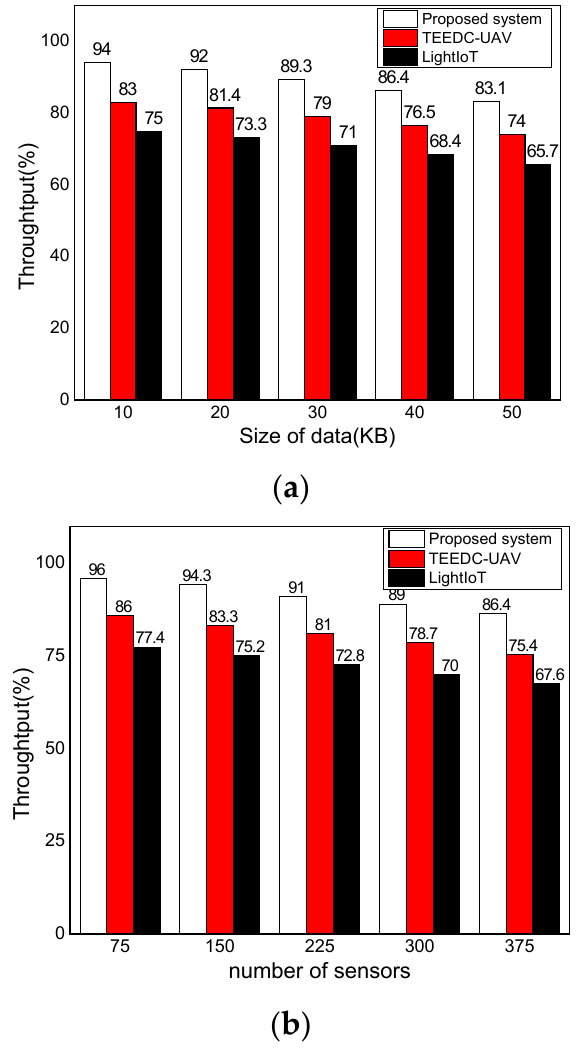
Figure 4. Performance results for varying data sizes and sensors for throughput. ( a ) Throughput with varying data size; ( b ) throughput with varying number of sensors.